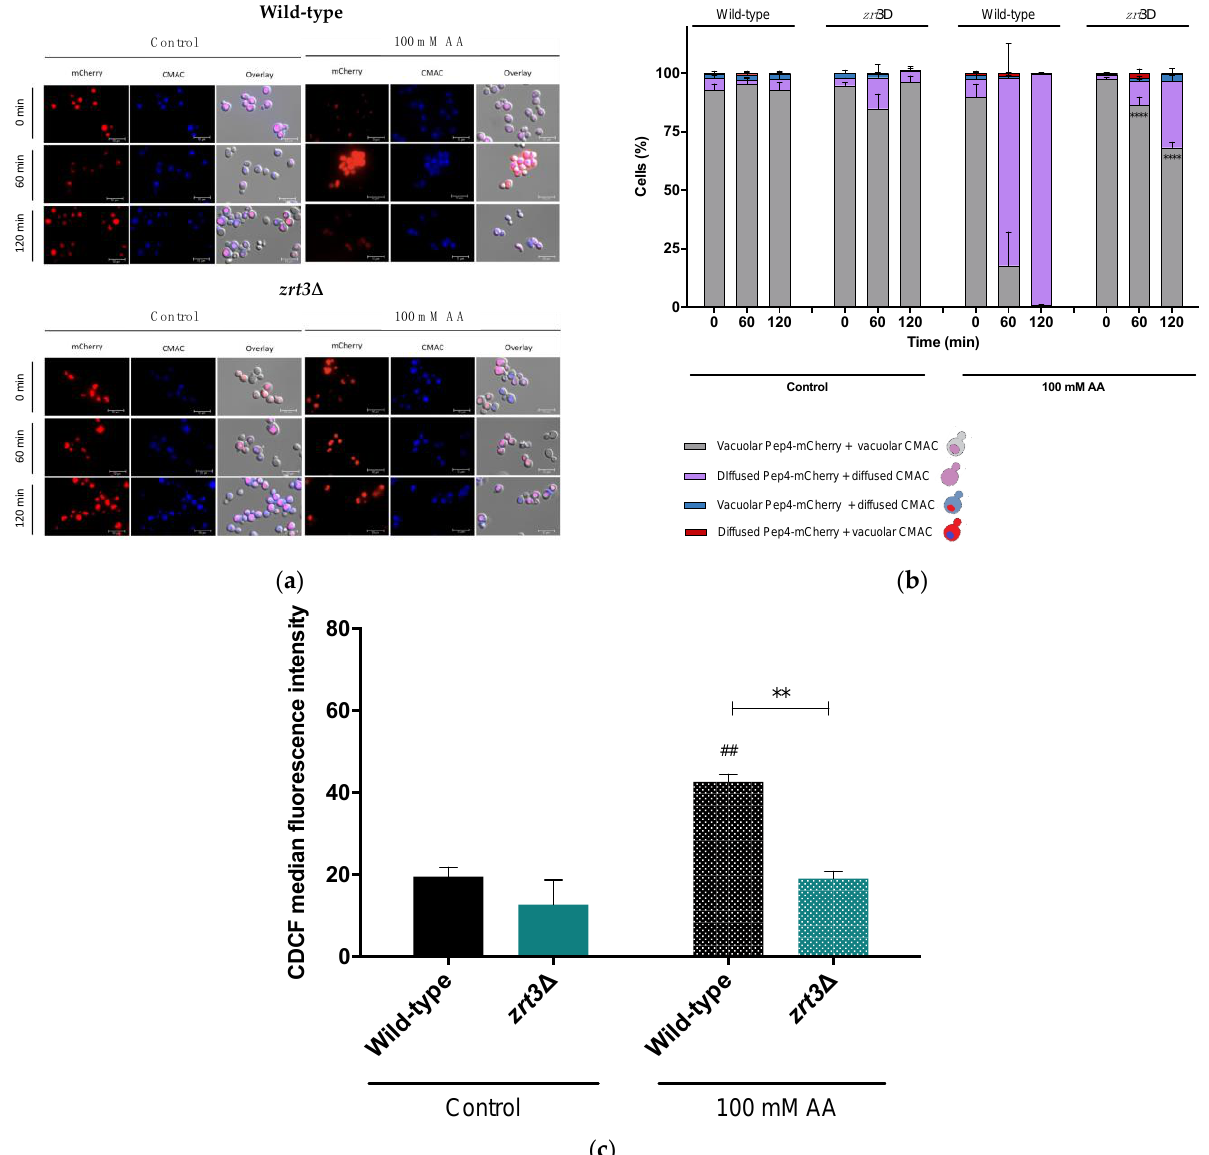
Figure 3. The effect of AA on Pep4-mCherry translocation from the vacuole into the cytosol, vacuolar membrane permeabilization and vacuolar pH in S. cerevisiae wild-type and zrt3 ∆ strains treated with AA. ( a ) Representative fluorescence microscopy images of wild-type and zrt3 ∆ cells trans- formed with Pep4-mCherry. Cells were incubated up to 120 min with or without AA and then stained with 2 µ M CMAC to assess vacuole membrane integrity. Cells were observed under the fluorescence microscope with a 100 × oil immersion objective. ( b ) Quantification of Pep4-mCherry localization and cells displaying VMP. At least 300 cells were counted for each condition. Values are the mean ± SEM ( n = 3). Statistical analysis was performed by two-way ANOVA. **** p < 0.0001 in com- parison with AA-treated wild-type cells. ( c ) Quantification of CDCF median fluorescence intensity of S. cerevisiae BY4741 wild-type and zrt3 ∆ cells 60 min after AA treatment (100 mM), pH 3.0. Cells were stained with 1.6 µ M CDCFDA and analyzed by flow cytometry. Values are the median ± SEM ( n = 3). Statistical analysis was performed by two-way ANOVA. ## p < 0.01 in comparison with the control of wild-type cells; ** p < 0.01 in comparison with the AA-treated wild-type